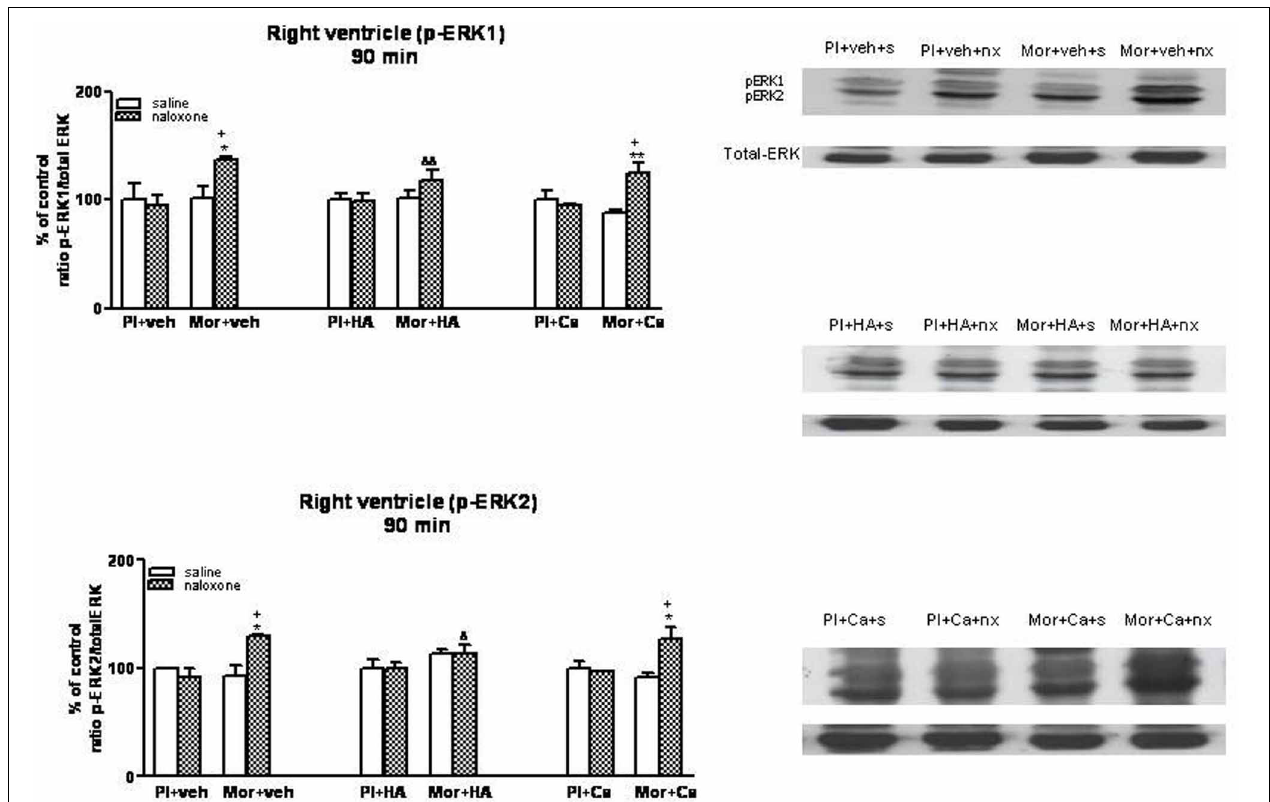
FIGURE 5 | Western blotting analysis of phospho (p)-ERK1 and phospho (p)-ERK2 immunoreactivity levels in the right ventricle 90min after saline (s) or naloxone (nx) administration to placebo (Pl)- or morphine (Mor)-treated rats receiving vehicle (veh), HA1004 (HA) or calphostin (Ca). The immunoreactivity corresponding to ERK1 or ERK2 is expressed as a percentage respect to the control group (Pl + veh + saline; defined as 100%